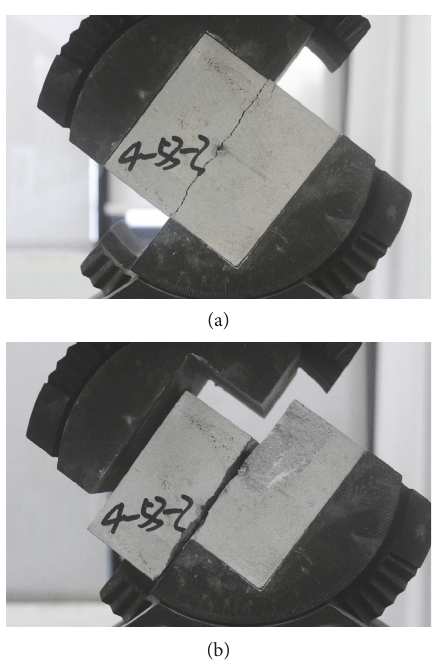
Figure 6: Shear failure of the test sample. (a) Beginning of shear slip; (b) complete failure of the test